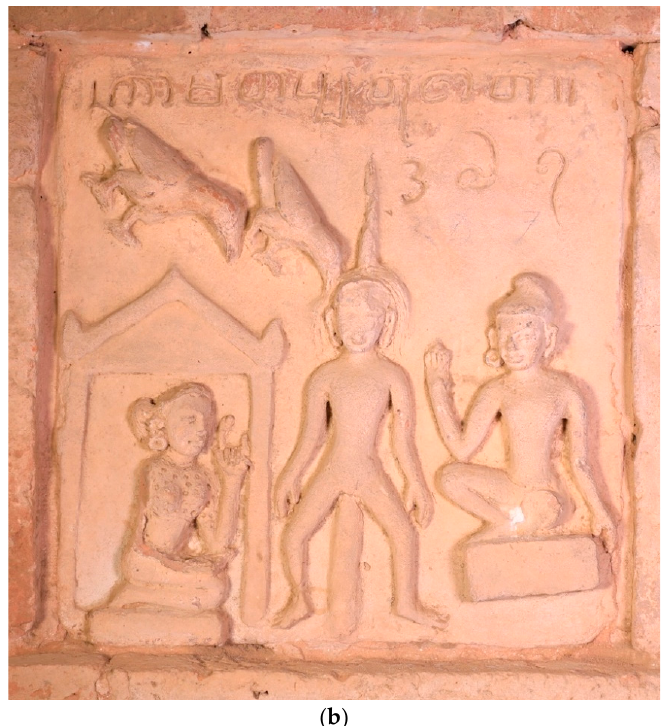
Figure 39. ( a ) Pagan, Myinkaba Kubyaukgyi, 1112 AD K ā mavil ā pa J ā taka, 297. ( b ) Pagan, Hpetleik Stupa, 11th century. K ā mavil ā pa J ā taka, 297.